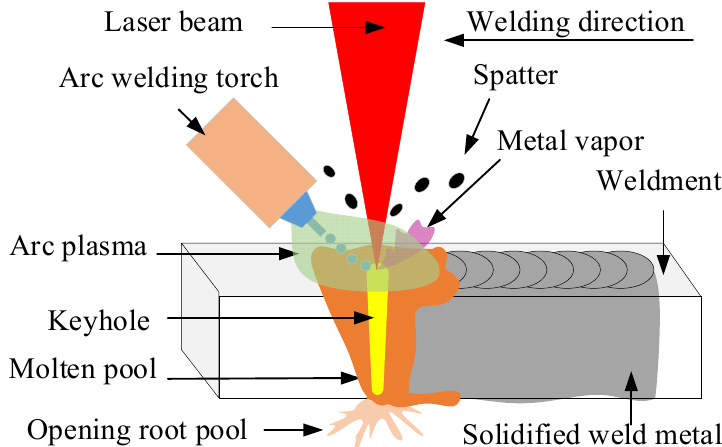
Figure 4. Schematic diagram of Laser-MIG hybrid welding.